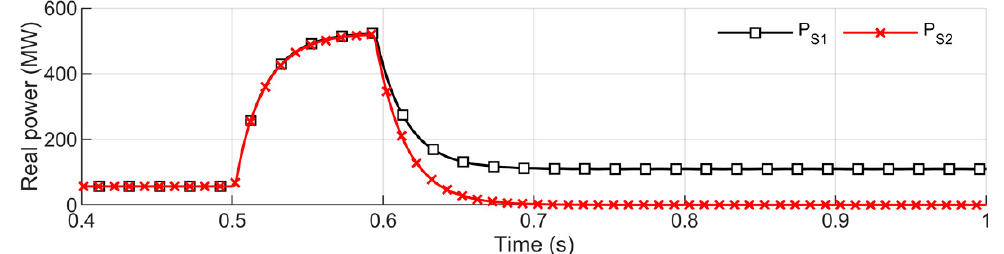
Figure 12. Currents in HTS cables in case DCRs operate normally: ( a ) HTS 1 ; ( b ) HTS 2 .